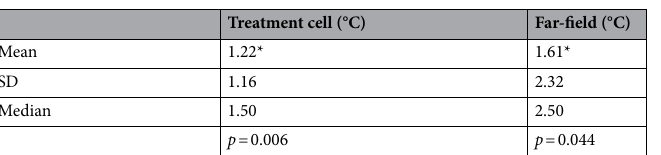
Table 2. Summary statistics of the maximum temperature after 14 min of therapy in the treatment and far- field regions across the treated animals. Two-sided, two sample t -test; df =